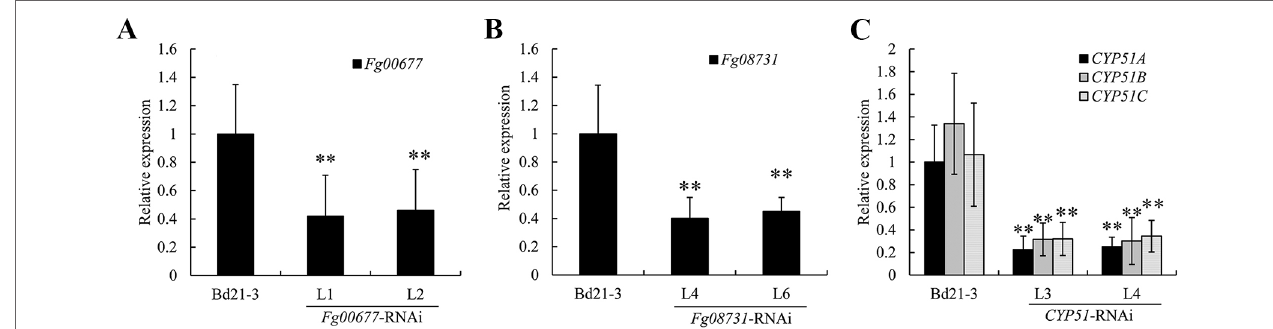
FIGURE 7 | Relative transcript levels of Fg00677 (a) , Fg08731 (B) , CYP51A , CYP51B , and CYP51C (C) in F. graminearum -inoculated spikelets. The expression values were normalized to the level of the beta-tubulin of F. graminearum , and the expression level of target genes in F. graminearum -inoculated non-transformed plants set at 1. Bars represent the means ± standard deviation of three biological replicates. Differences were assessed using Student’s t test. Double asterisks indicate P <